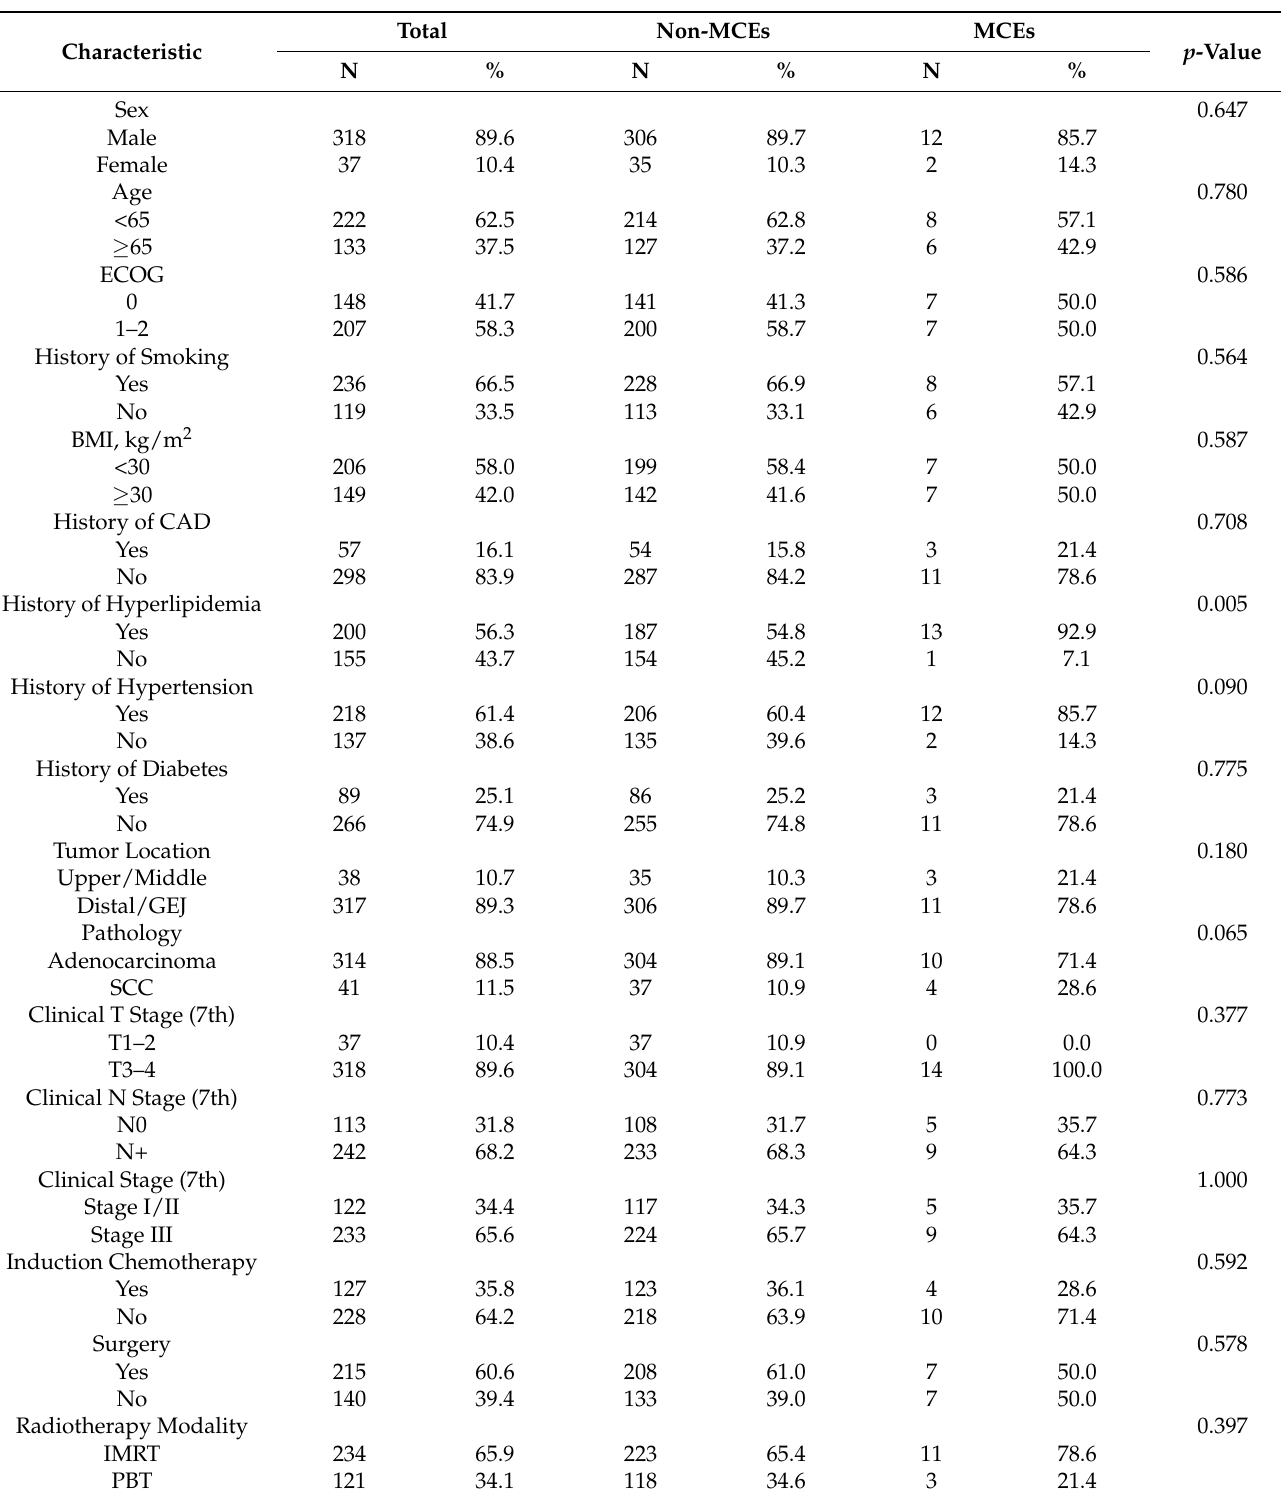
Figure 1. Additionally, detailed radiation dose distributions for the cardiac substructures are shown in Supplementary Figure S2. Table 1. Patients characteristics at